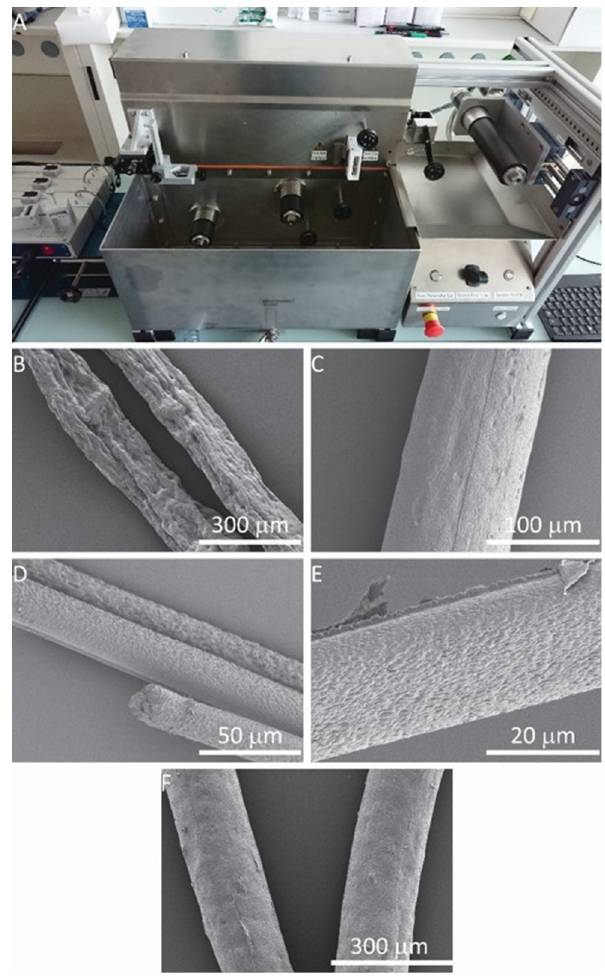
Figure 4. ( A ) Customized mini-wet-spinner used to collect fibers and microfluidic pumps used for flow control (left). ( B – E ) SEM images of TPU fibers. ( B ) TPU fiber spun at r = 2. ( C ) TPU fiber spun at r = 20. ( D ) TPU fiber spun at r = 50. ( E ) TPU fiber spun at r = 100. ( F ) TPU Fiber spun at r = 20 using a microfluidic spinneret with the main channel diameter of 1.2 mm.